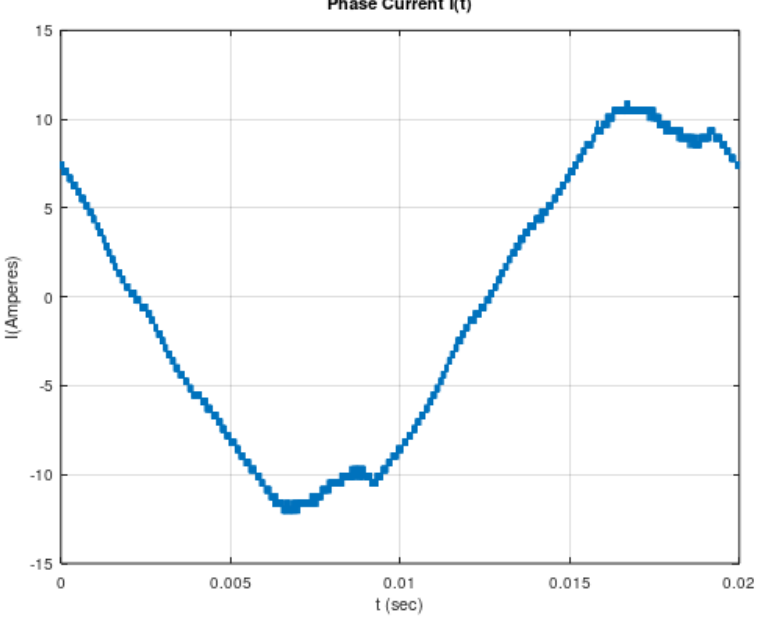
Figure 1. Measured electric current at the AC side of the inverter, from an 8 kWp roof PV generator.